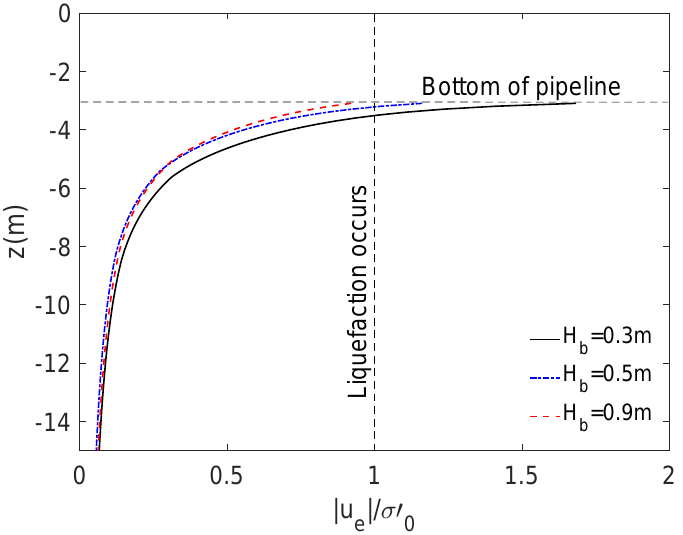
Figure 12. Distribution of the excess pore pressure ( | u e | / σ (cid:48) section through the center of the pipeline for various backfill